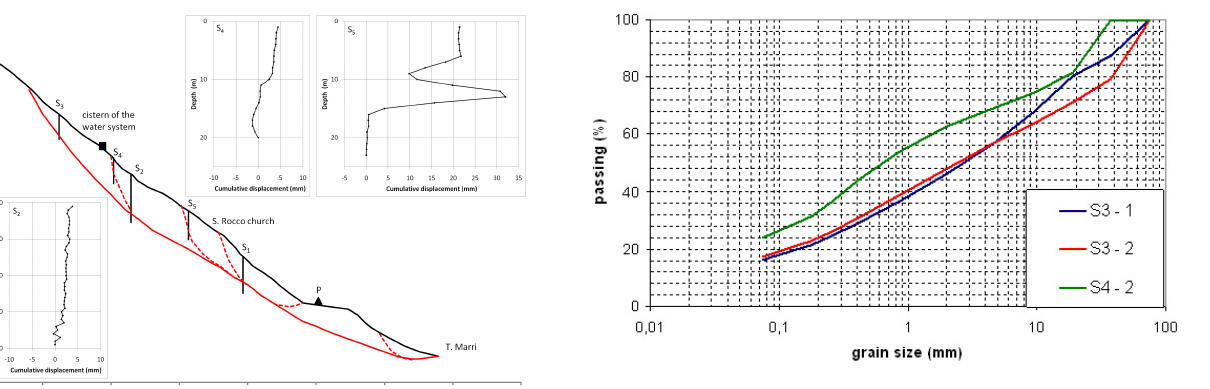
Fig. 7. Grain size distributions of samples taken at shallow depths in the gneissic cover (layer